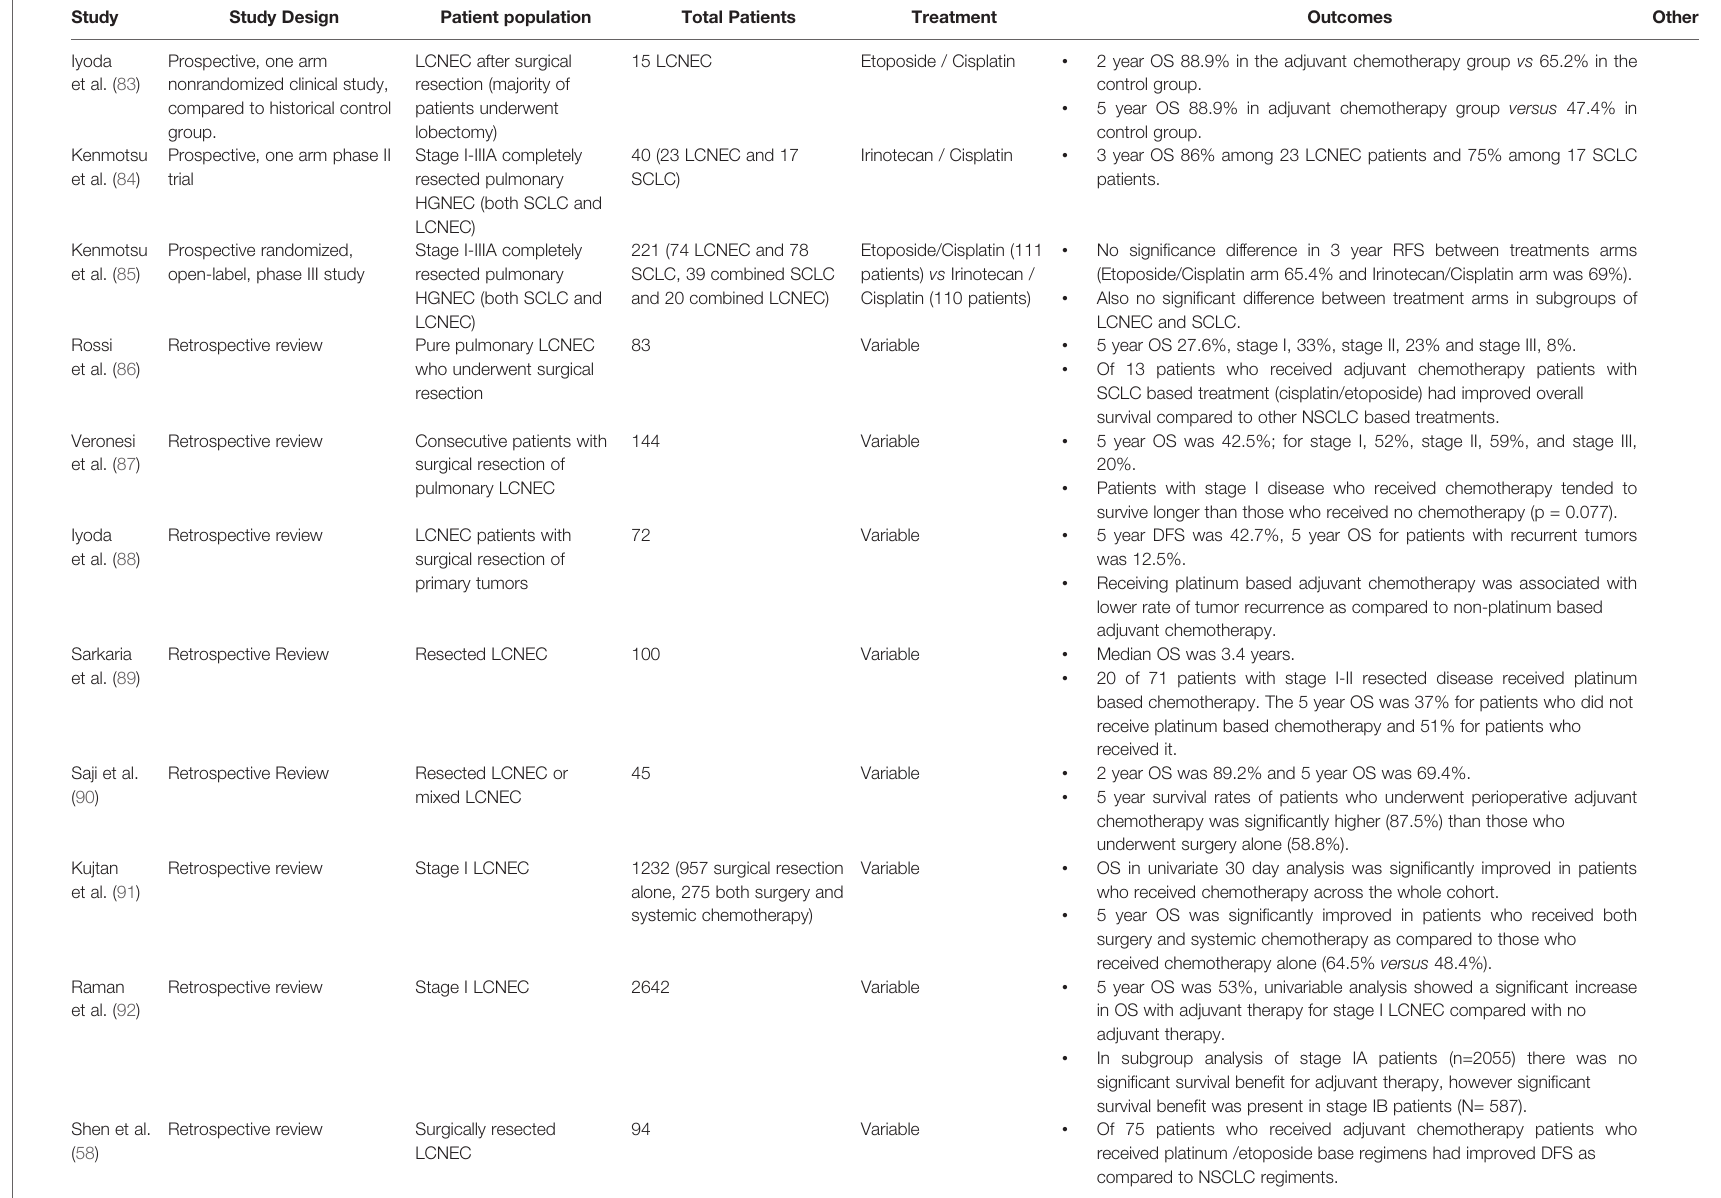
TABLE 5 | Key Papers Describing Adjuvant Therapy in Pulmonary LCNEC.